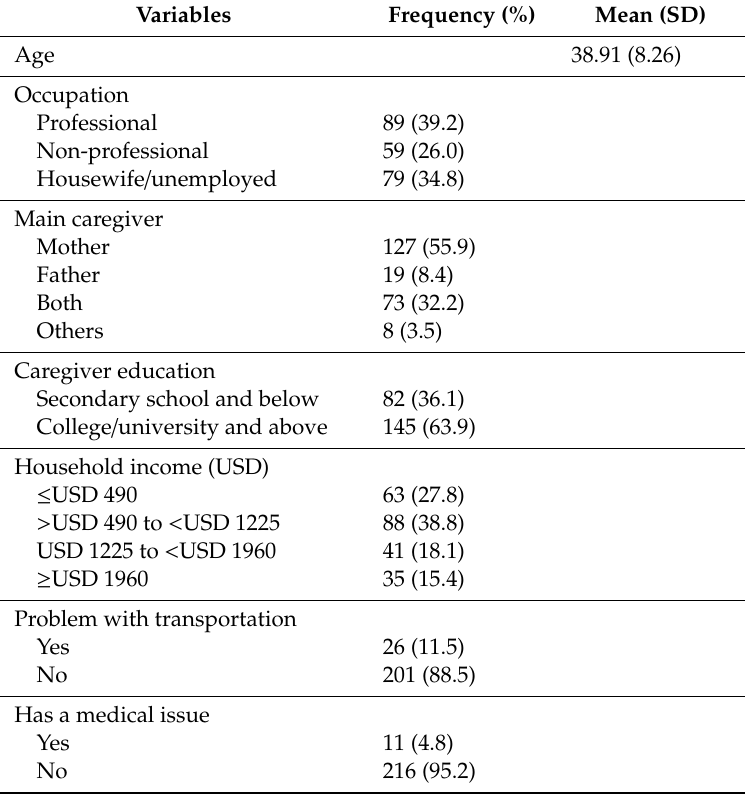
Table 1. Socio-demographic characteristics of the caregivers ( n =